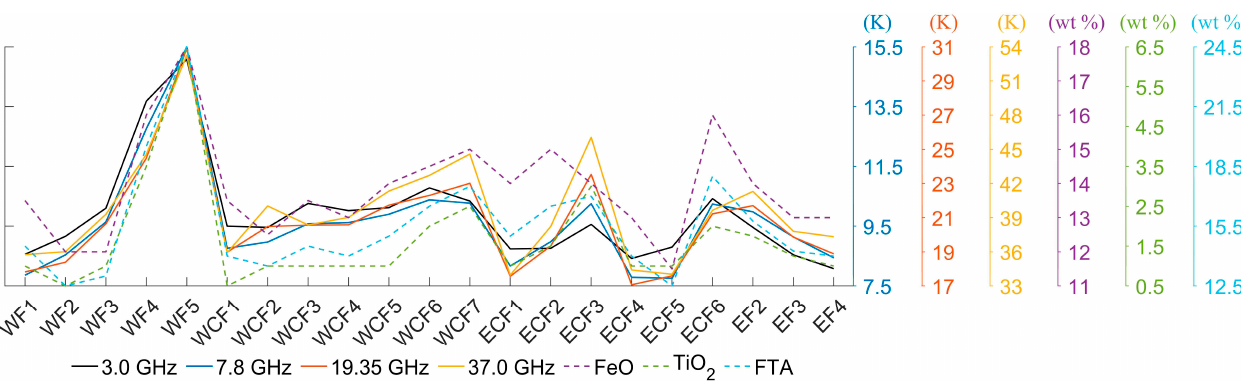
Figure 13. The SCREP-based FeO, TiO 2 , and FTA values mapped by Kramer et al. [2] and the four-channel TBDs of all units.